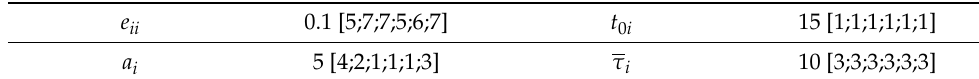
Table 2. Conditions of actuator